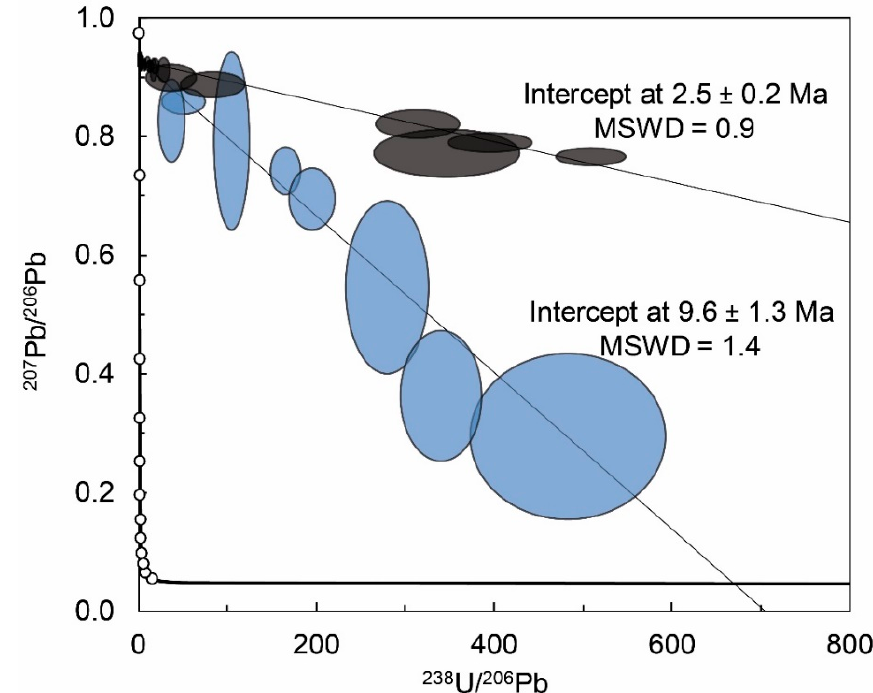
Figure 6. U-Pb dating of calcite sample 178 m, ages reflect non-anchored lower intercept ages and uncertainties are quoted at 2 s and comprise systematic uncertainties. Spot locations and details are reported in Supplementary Table S4 and Figure S4.